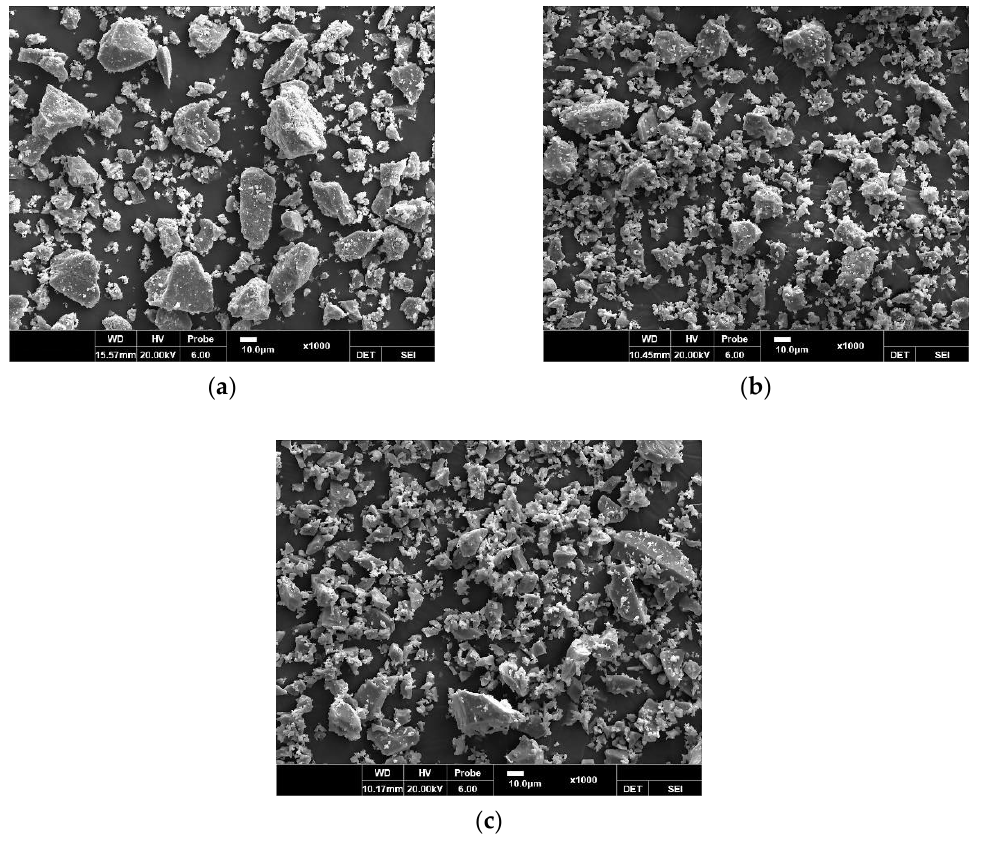
Figure 2. Scanning electron microscopy images: ( a ) OPC; ( b ) EPC; ( c ) GGBS.